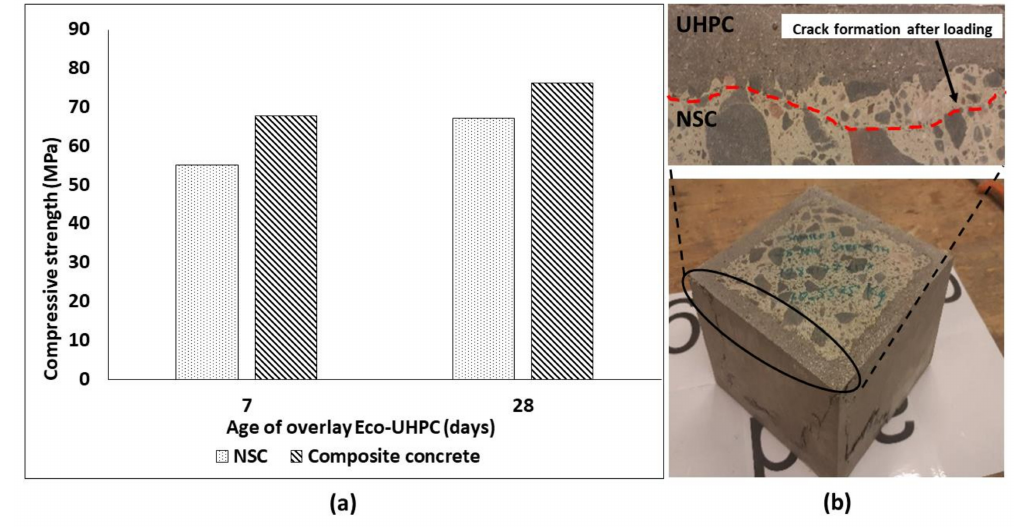
Figure 7. ( a ) Compressive strength development of composite cubes; ( b ) cube failure / crack formation after loading.